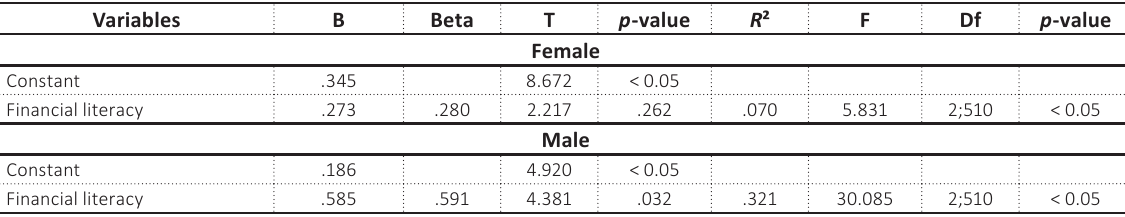
Table 4. Gender differences between financial literacy and business risk-taking Variables B Beta T p